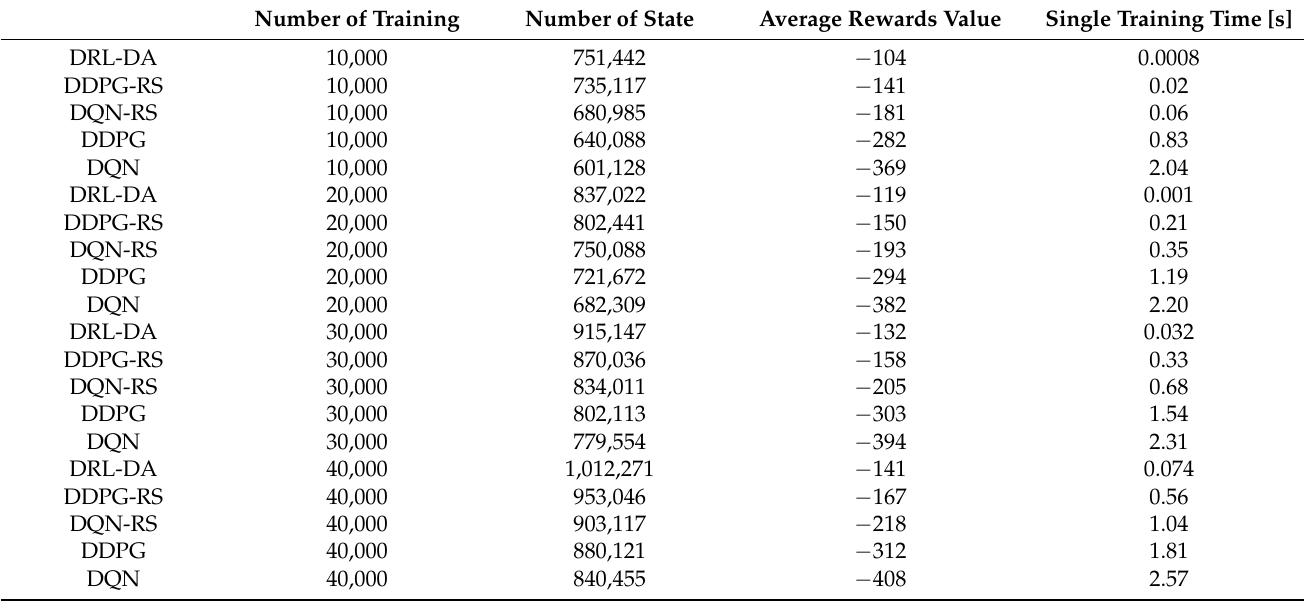
Table 8. Comparing the training session results of the proposed method with other